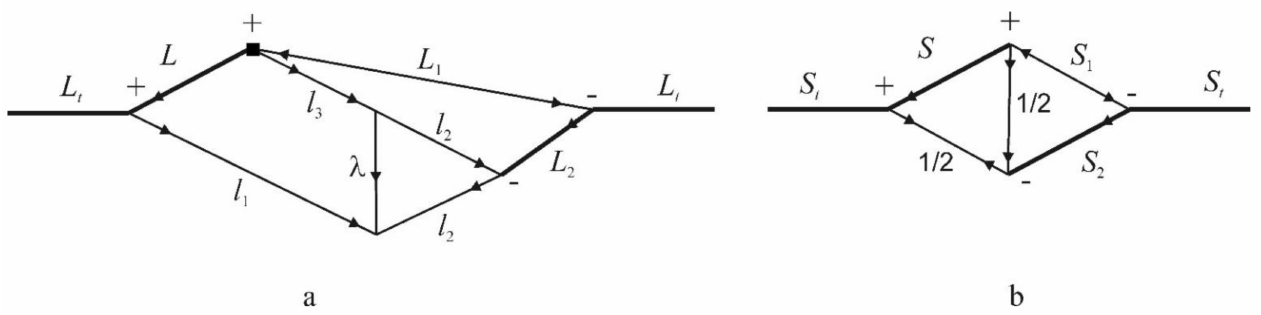
Figure 6. Angular momentum graphs for the calculation of angular weight factors for the interac- tion between initial state in photoionization 3 s − 1 3 d N and a the state 3 p − 2 3 d N + 1 . ( a ) Orbital part, ( b ) spin